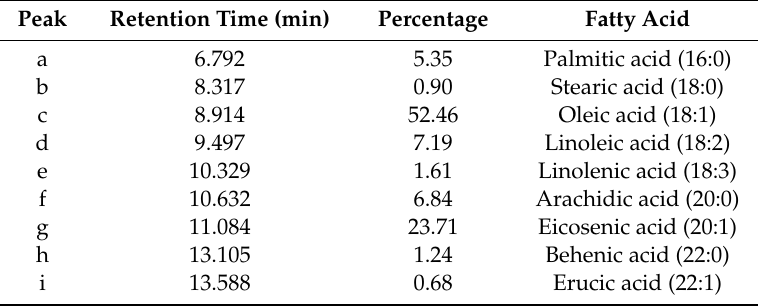
Table 1. Fatty acid composition of Sapindus mukorossi seed-extracted oil by gas chromatography- mass spectrometry.